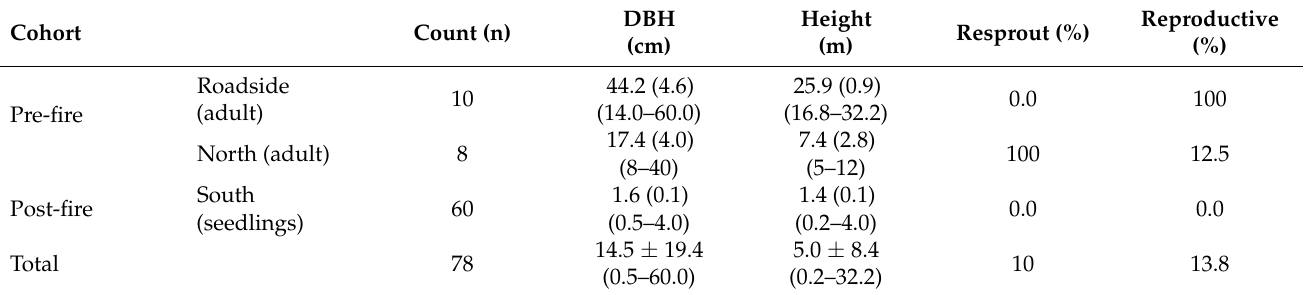
Table 1. Size and reproductive status of the three cohort groups sampled. Statistics include mean ± standard error (minimum–maximum) for diameter at breast height (DBH, in cm) and height (in meters). The proportion of trees with resprouts and with reproductive organs (flowers and capsules) is also listed. In the post-fire group, mean DBH does not include 37 seedlings smaller than 1.30